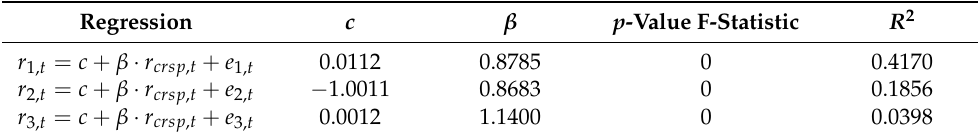
Table A5. Estimated parameters and statistics of the three regressions.